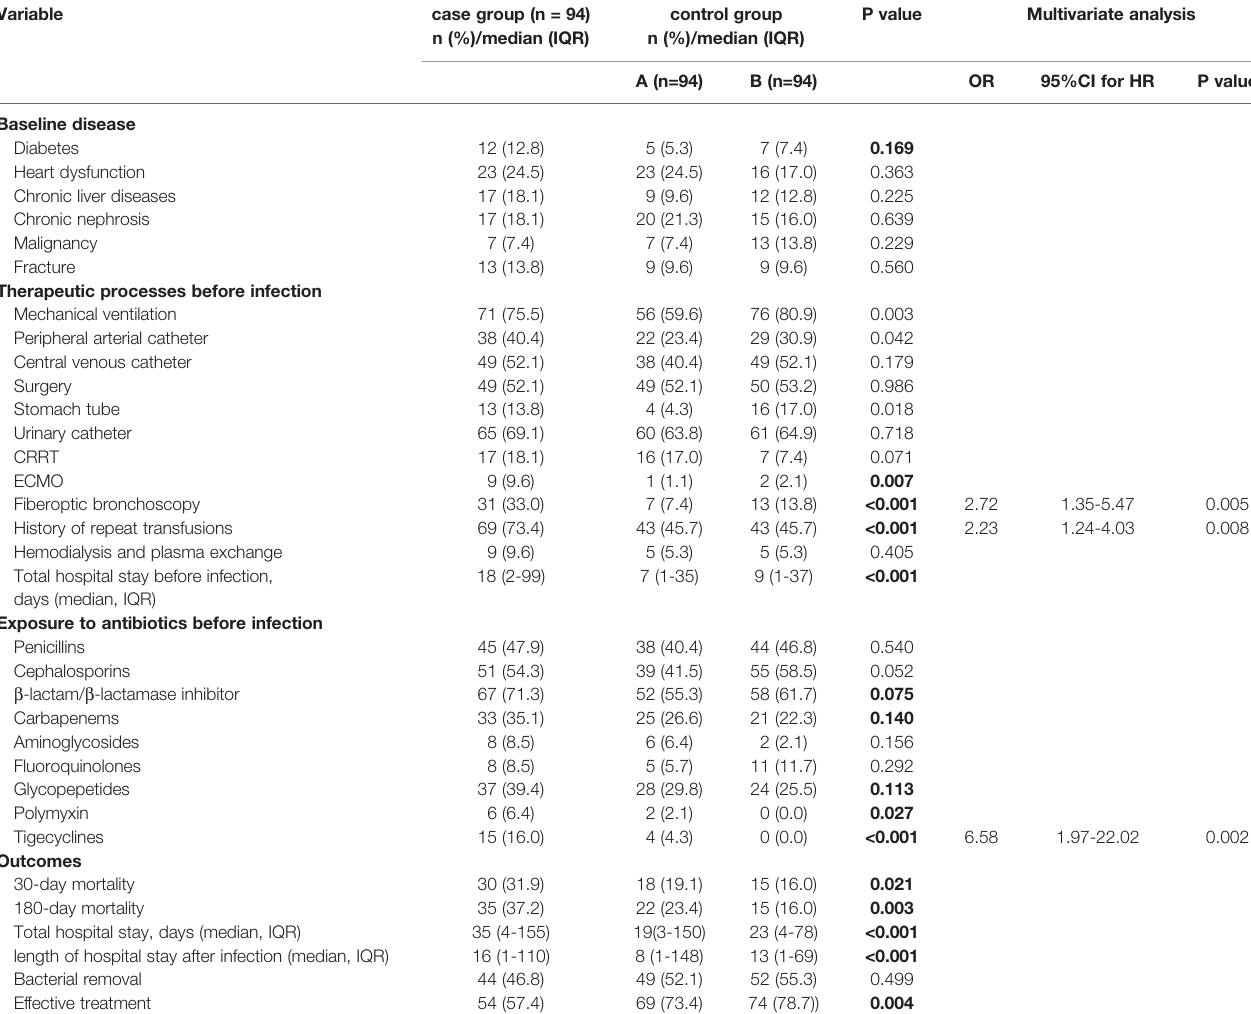
TABLE 1 | Univariate analysis and multivariate analysis of risk factors for CRKP and CRAB co-infected patients (case group) compared to control patients with CRKP infection alone (control group A) and control patients with CRAB infection alone (control group B). Variable case group (n = 94) n (%)/median